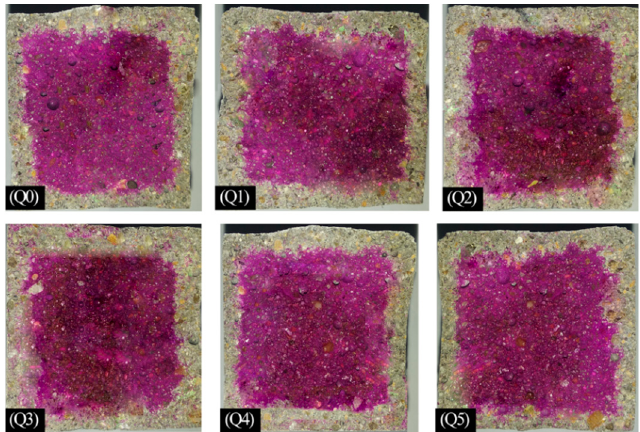
Figure 6. Image of carbonation depth under ultrasonic vibration agitation (7 d) .